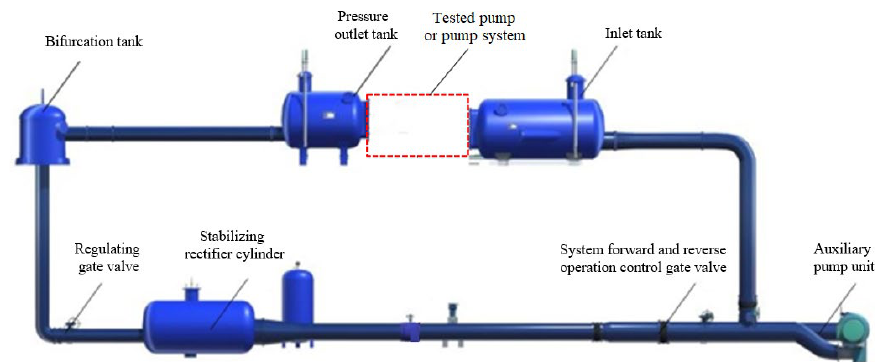
Figure 3. Schematic diagram of the high-precision hydro-mechanical test bench.